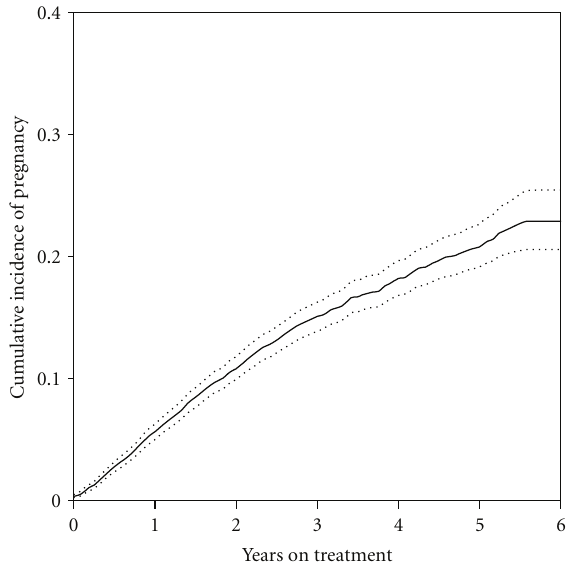
Figure 1: Cumulative incidence of first pregnancy among 5,996 women initiating HAART in Johannesburg, South Africa, from time of HAART initiation, with 95% confidence